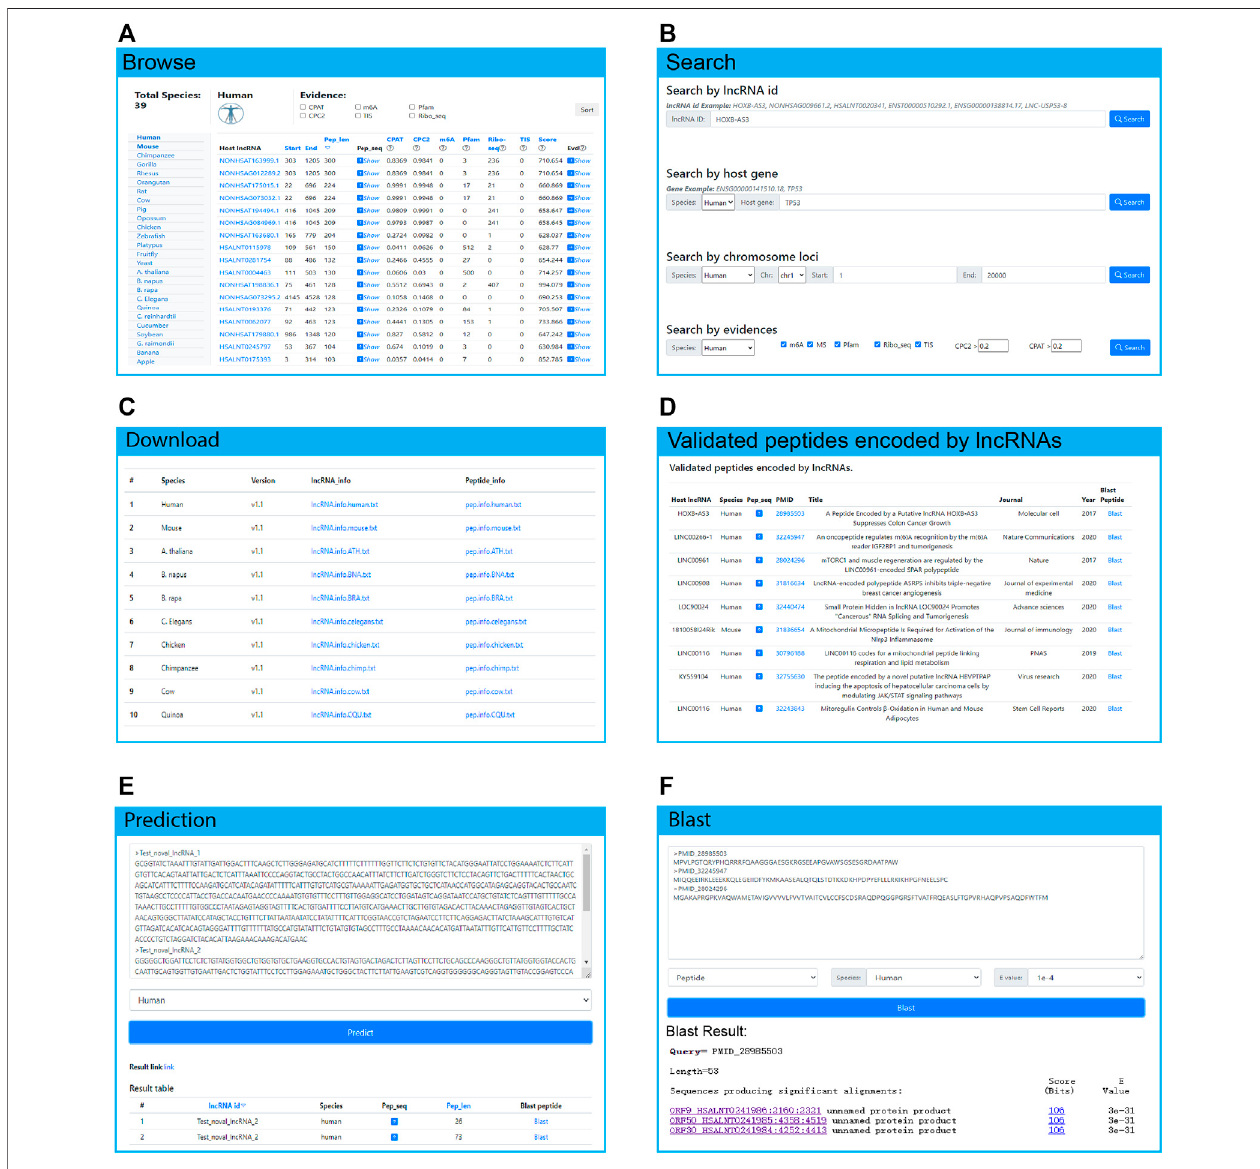
FIGURE 3 | The functional modules of the LncPep database. (A) Users can browse the whole database by species. (B) The search page provides a search of lncRNA IDs, host genes, chromosome loci, and evidence. (C) All datasets deposited in LncPep are free to download. (D) The experimentally validated peptides were collectedandbrowsed. (E,F) Apredictionand BLASTsearchservicewasprovided toexplorenovellncRNAs and peptides. Species ande-valuesaresetasparameters to choose.